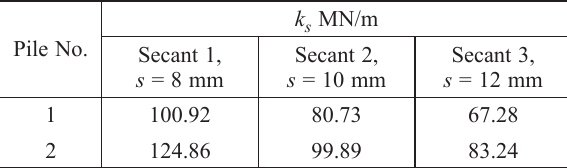
Table 2. Pile stiffness from the static load test